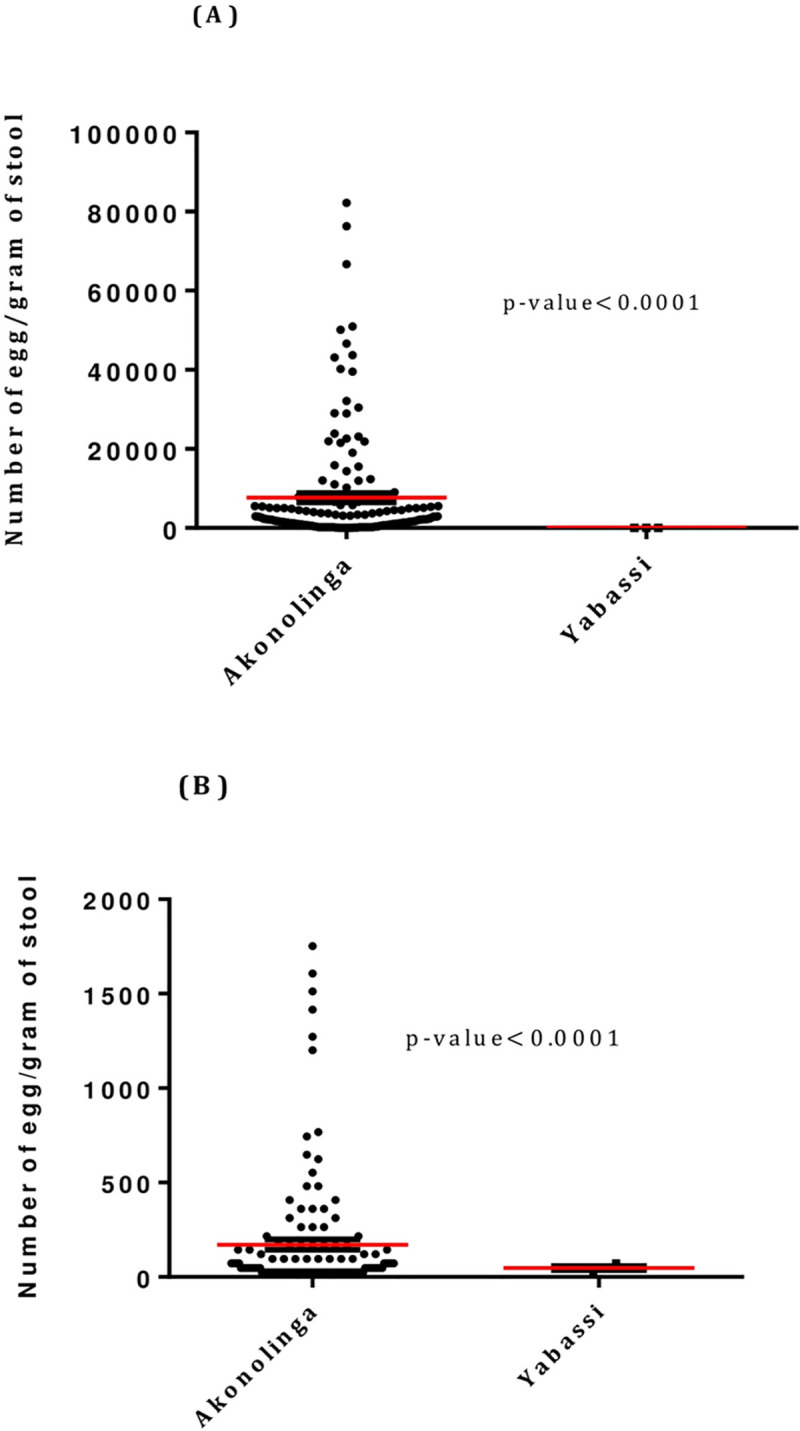
Intensities of STH infections in the Akonolinga (dark bars) and Yabassi (grey bars) health districts.Each black dot represents the number of eggs harbored by a single participant, either for A. lumbricoides (A) or for T. trichiura (B). The red line represents the mean number of eggs in each of the health districts.